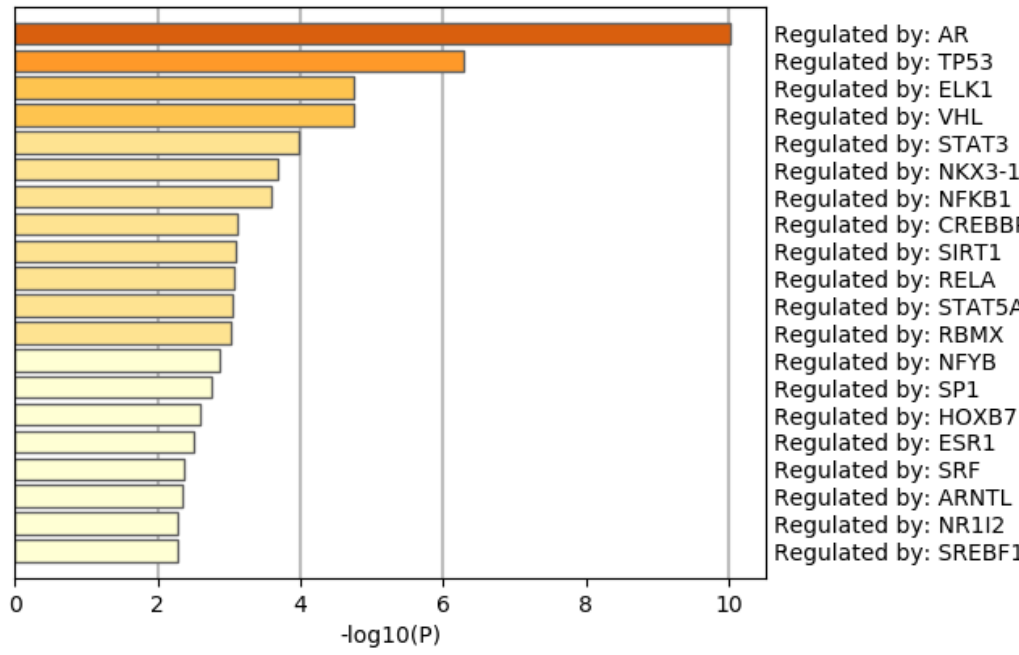
Figure 9. Summary of enrichment of the TRRUST category of Metascape when 1785 protein-coding genes included in 1447 genomic regions selected by TD-based unsupervised FE are